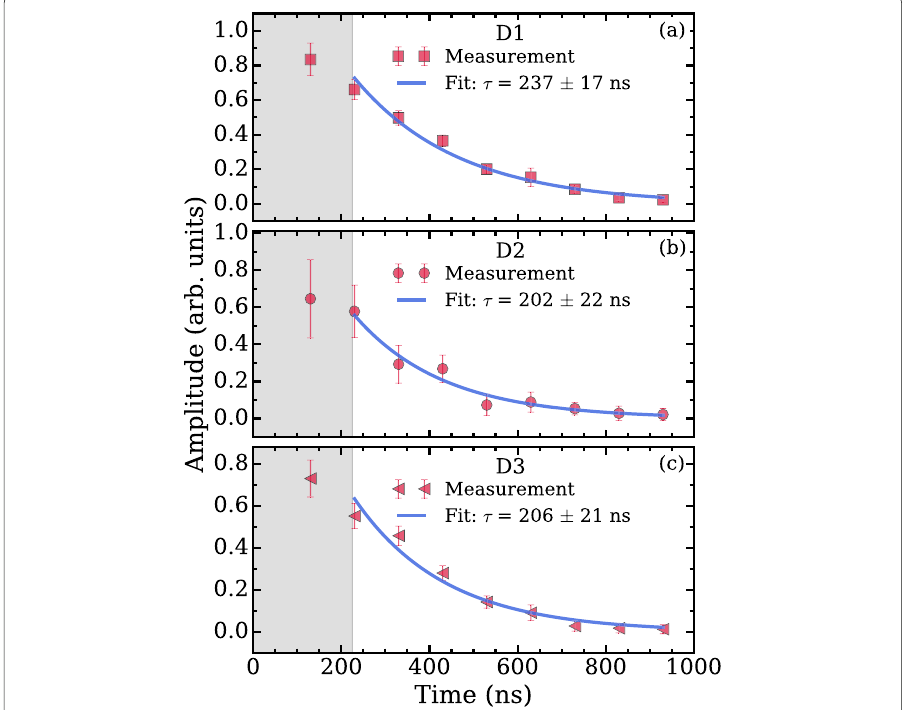
Fig. 7 Lifetime spectra for 2 3 S 1 atoms obtained from smoothed quenching data using detectors D1-3, as explained in the text. The solid curves are exponential fits to the data. The grey bands represent the region in which data are not used in the fit since it takes 200 ns until all atoms have entered the